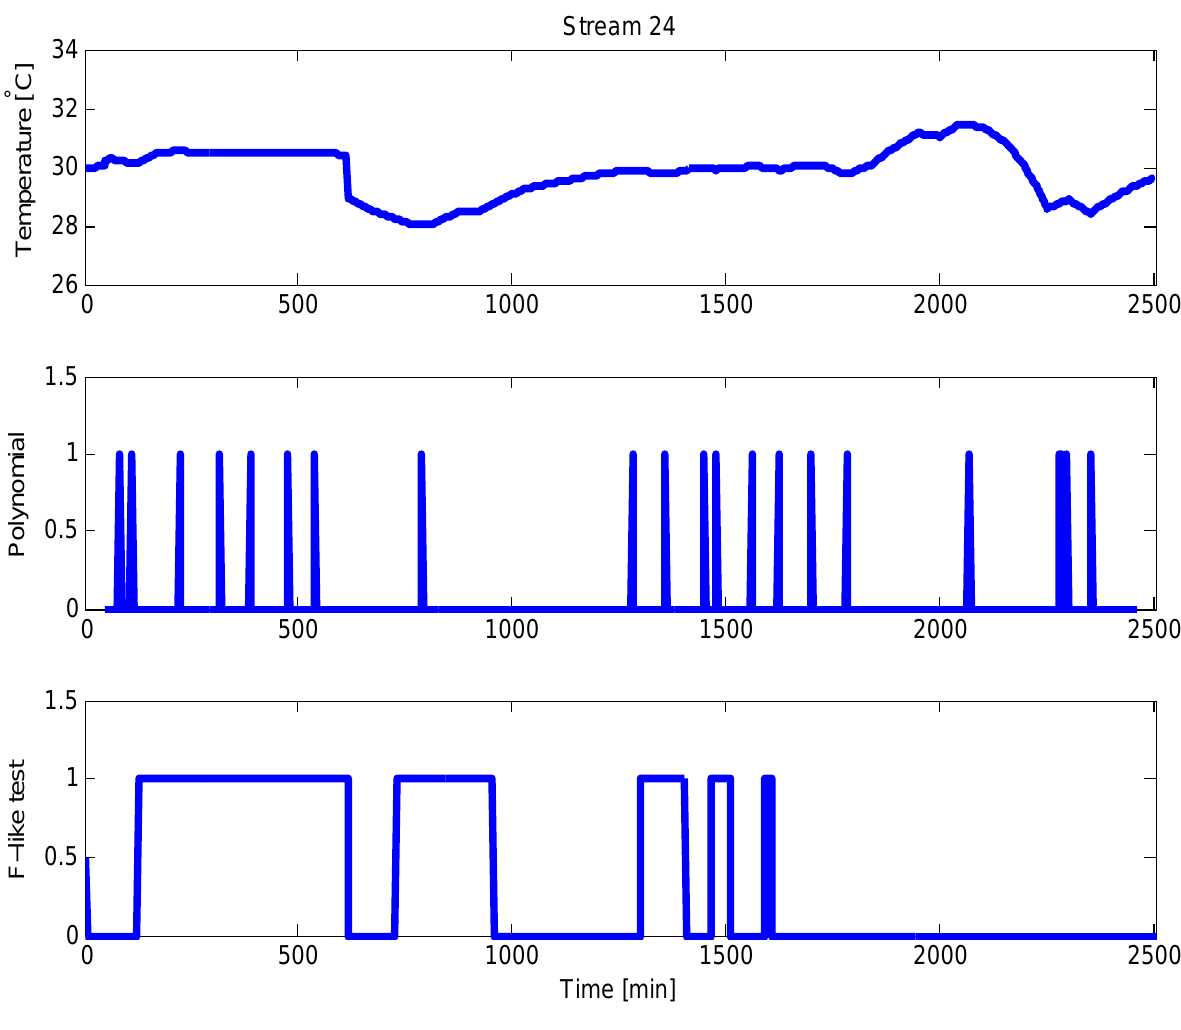
Figure 15. Depropanizer reflux drum case temperature experimental data and SSI results for the F-like test and the polynomial